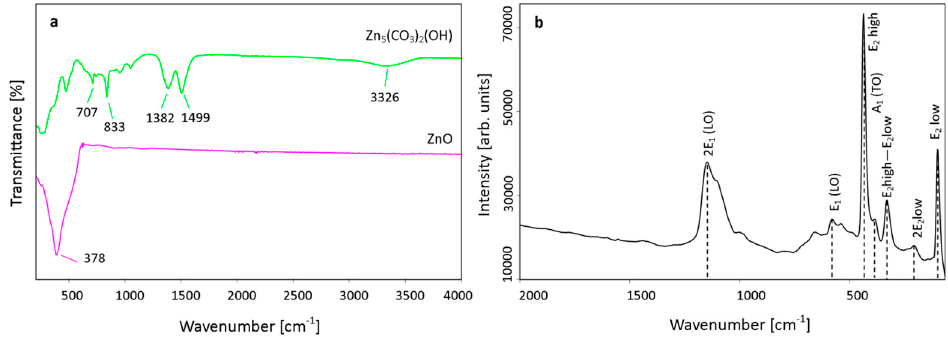
Figure 7. FT-IR (ATR) spectra of Zn-Carb and ZnO powders (type B) ( a ), and Raman spectrum of ZnO powder (type B) ( b ).